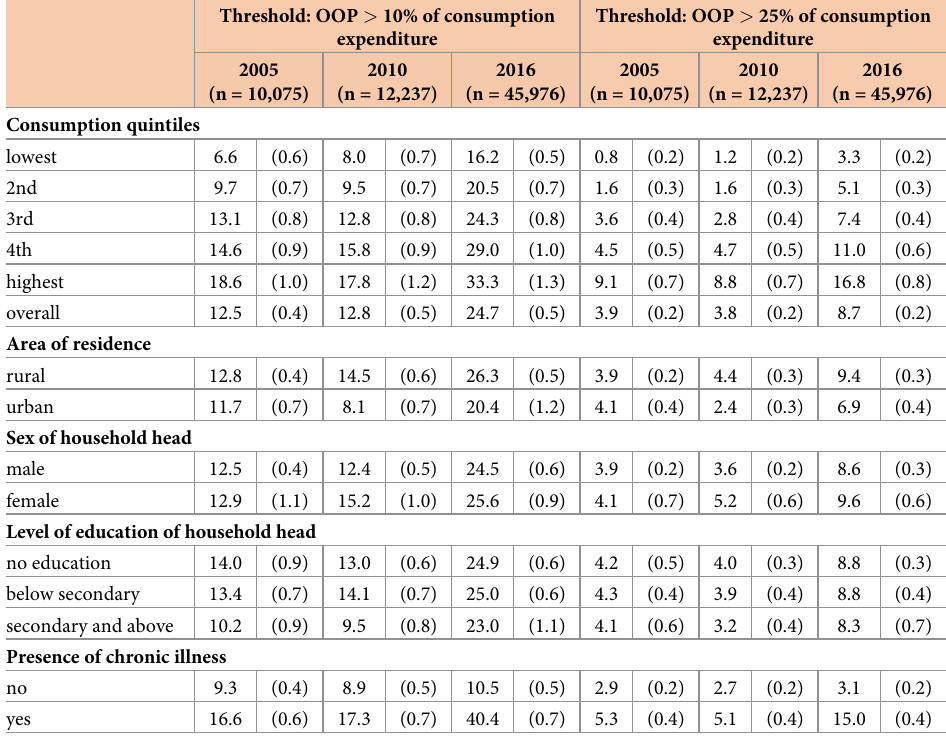
Table 4. The levels and distributions of the incidence of catastrophic health expenditure (%) by year; budget share method (SDG indicator